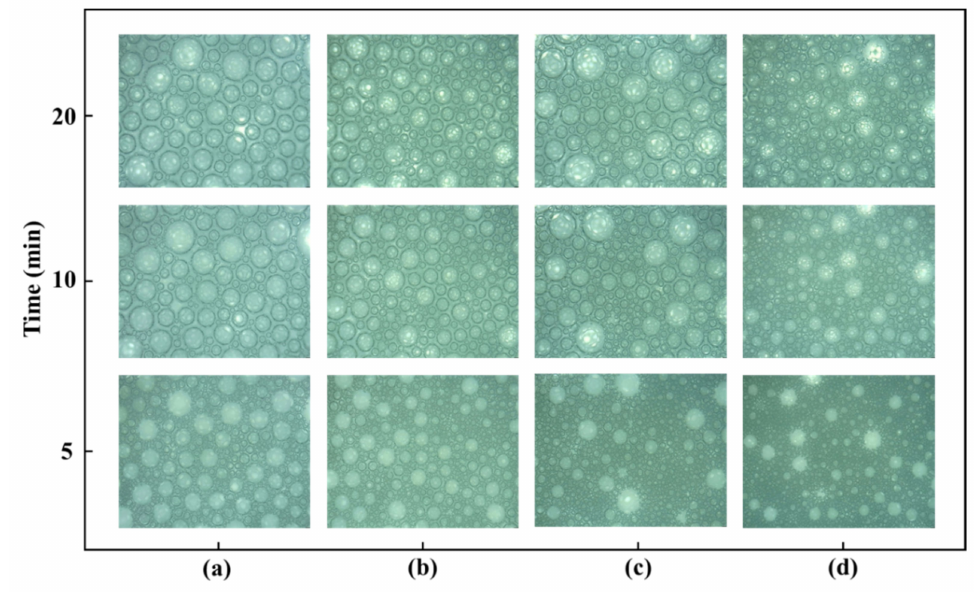
Figure 3. Coarsening process of different foams. ( a ) APG, ( b ) APG with 50 g/L NaCl, ( c ) APG with 50 g/L MgCl 2 , and ( d ) APG with 50 g/L CaCl 2 .